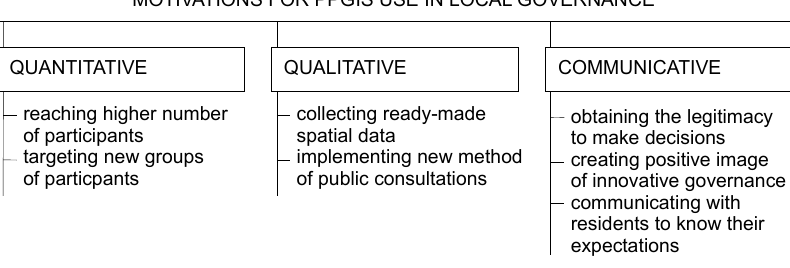
Figure 6. Motivations for PPGIS use in decision-making processes. Source: own elaboration.